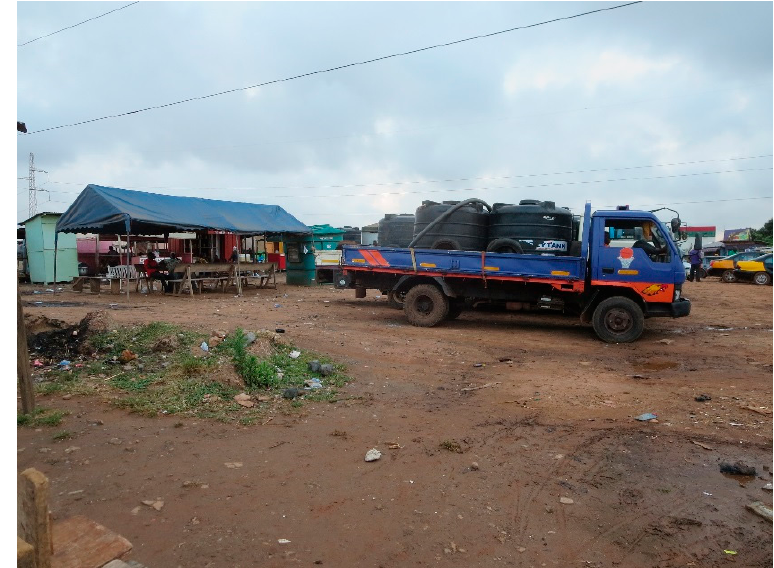
Figure 1. Polytank truck parked at drivers’ station. Source: Authors, October 2015.